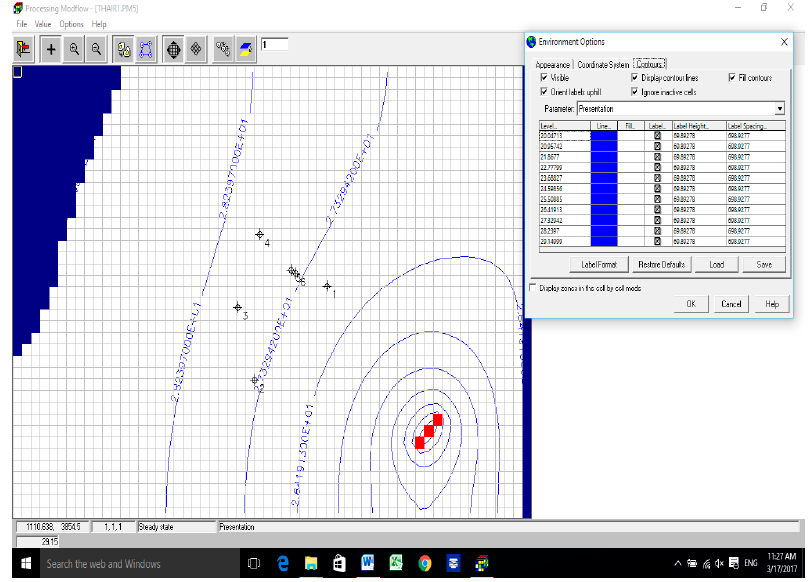
Figure 7. Groundwater equipotential contour lines for Scenario 1.